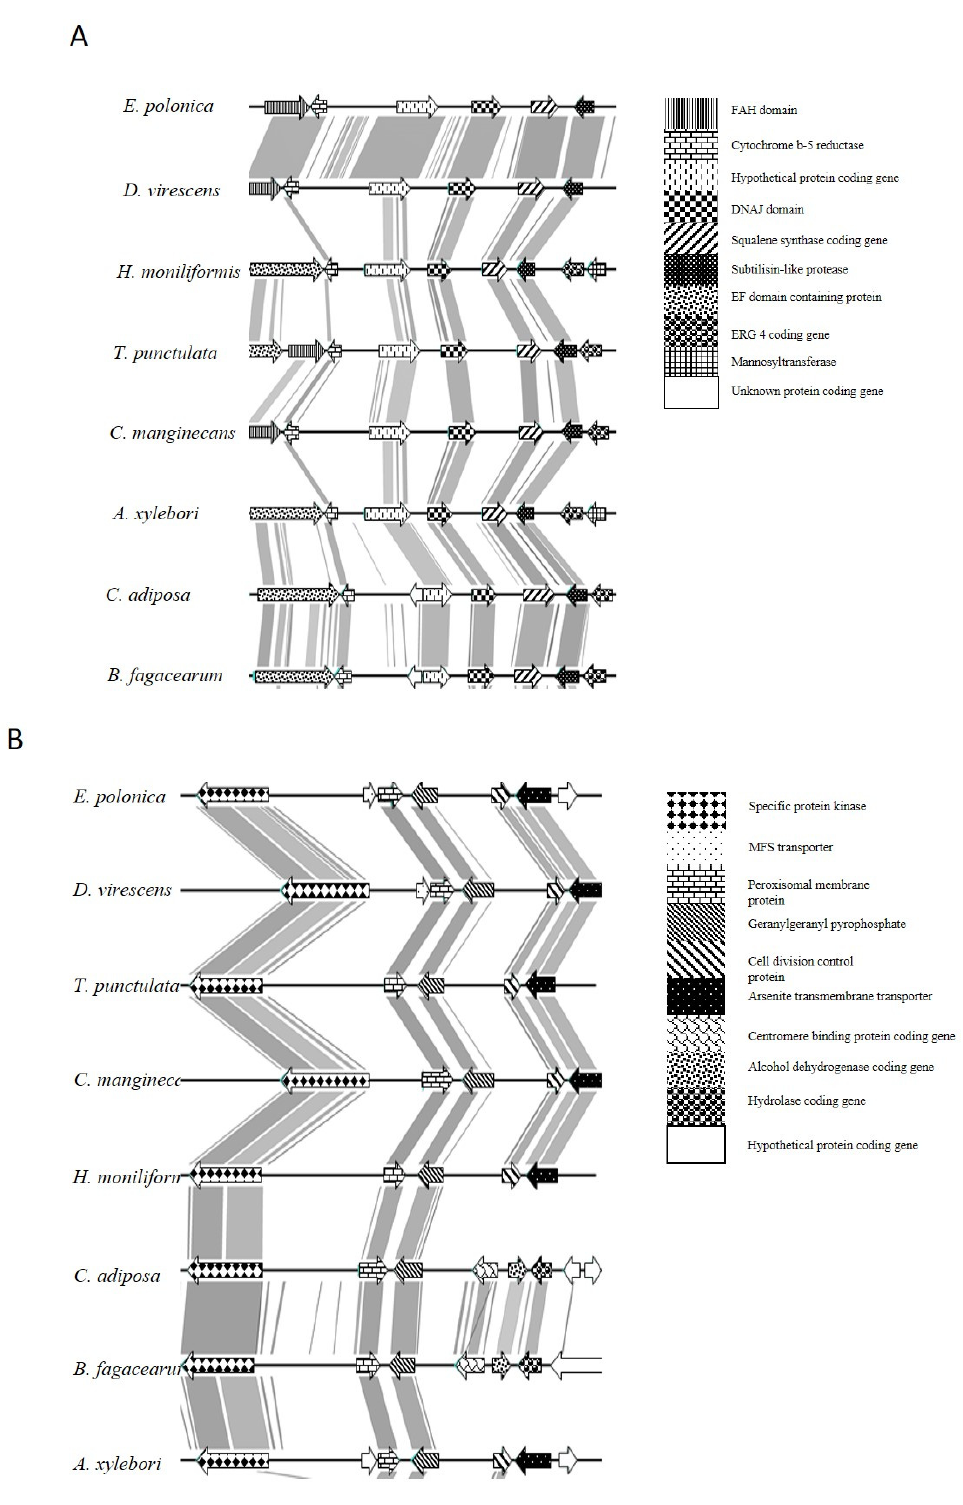
Figure 1. Comparison of gene content and organization of the two terpenoid biosynthesis clusters identified in different members of Ceratocystidaceae. One of these clusters ( A ) contained genes needed for ergosterol biosynthesis. The other contained a gene encoding geranylgeranyl pyrophosphate synthetase ( B ) which may be involved in protein prenylation or potentially in the production of carotenoids or antimicrobial diterpenes (Keller et al., 2005). The direction and relative size of genes are indicated by arrows. The function of putative synthetic genes is shown by different patterns. Each color/pattern represents a specific gene.